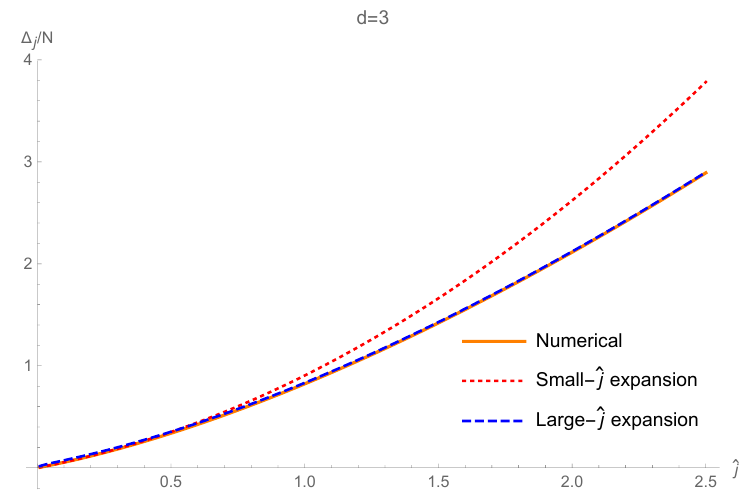
Figure 1 . The scaling dimension ∆ j /N as a function of ˆ j = j/N in d = 3 . The solid line was obtained by numerically solving (2.49). The small and large ˆ j curves correspond to eq. (2.55) and (2.63), keeping the first two terms in each expansion. The analytic large ˆ j expansion is remark- ably close to the exact answer even for relatively small ˆ j